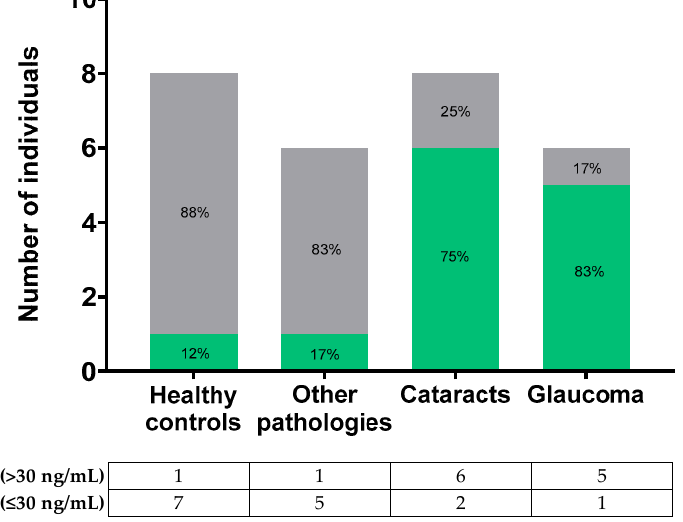
Figure 5. Number of individuals or patients over and below the pathological threshold in the different groups.